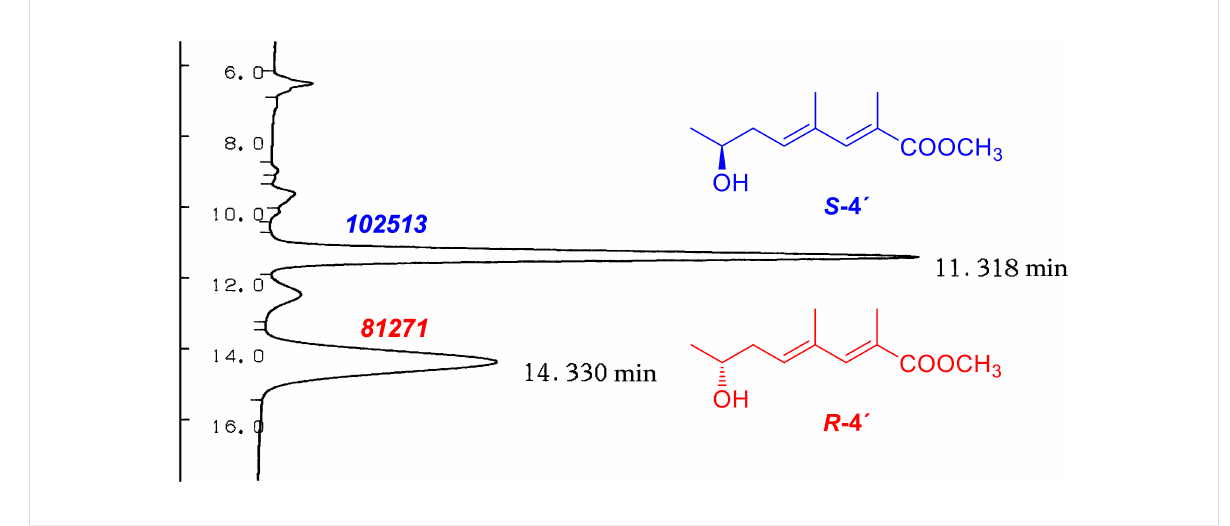
modified V22, a different medium. This compound was isolat- ed by the same sequence of chromatographies as above, yielding 45 mg from a 6 L culture. The molecular formula was determined to be C 18 H 22 N 2 O 3 based on its NMR and